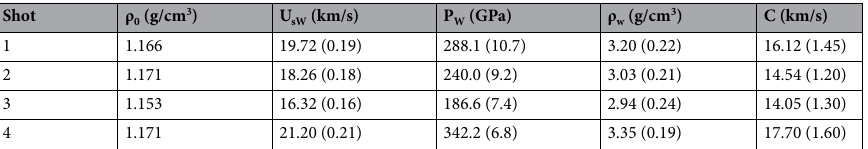
Table 1. Experimental conditions of initial precompressed water (density) and shocked water (shock velocity, pressure, density). Uncertainties are given in parentheses.